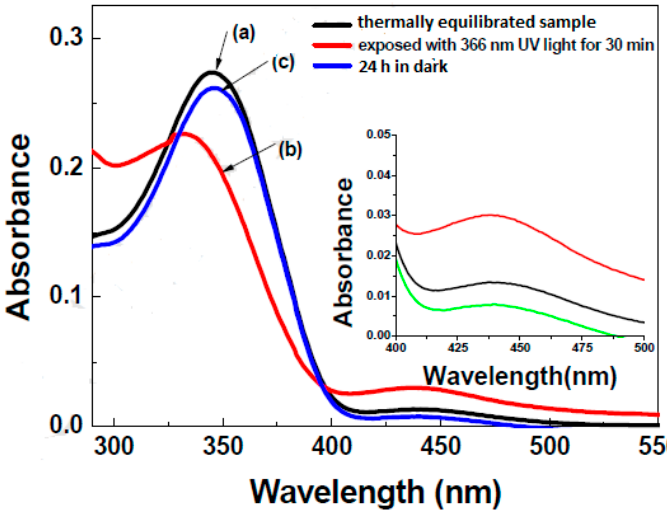
Figure 19. The UV-vis absorption spectra of compounds 71 ( a ) before the light illumination, ( b ) upon the UV light exposure ( λ = 365 nm) for 30 min and ( c ) after keeping in the dark for 24 h. The inset indicates the enlarged area of 400–500 nm (Reproduced with permission from ref. [156], copyright Elsevier 2020 , https://doi.org/10.1016/j.dyepig.2018.12.028 ) .